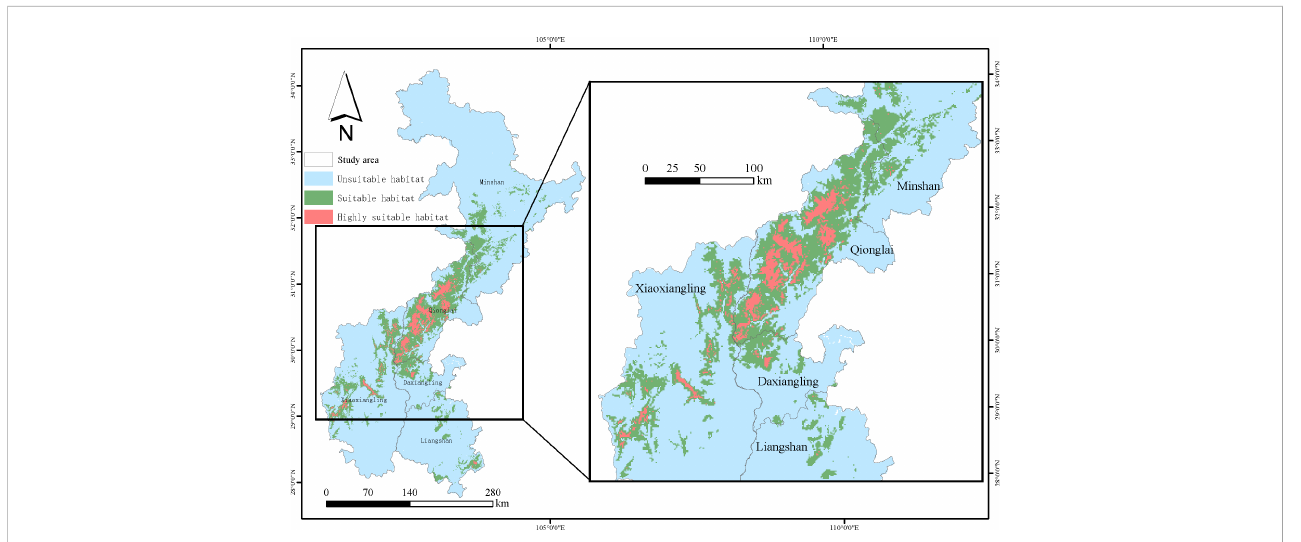
FIGURE 3 Suitable habitat of sambar, obtained from the MaxEnt species distribution